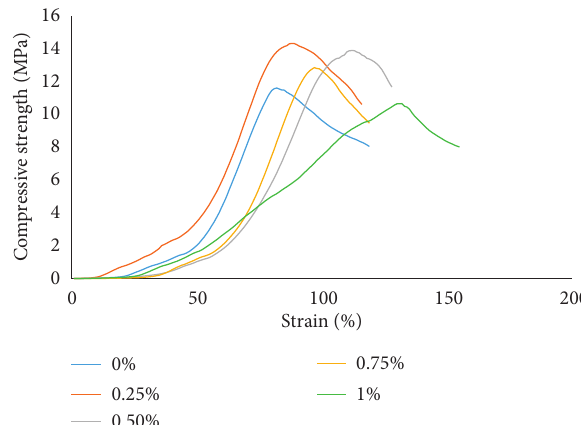
Figure 5: Compressive stress and strain relationship.